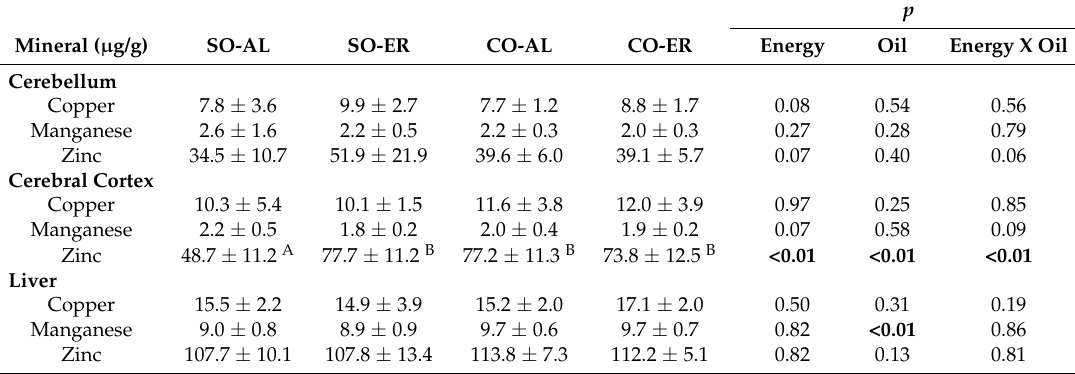
Table 6. Tissue mineral analysis.